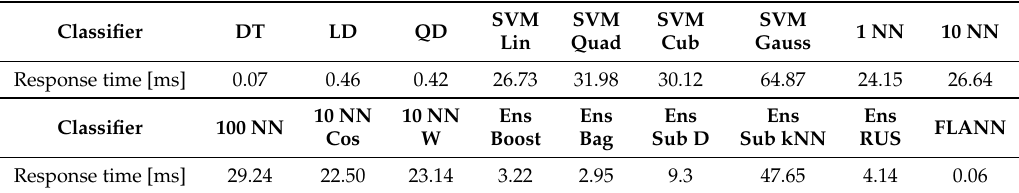
Table 12. Average response times of the individual classifiers.